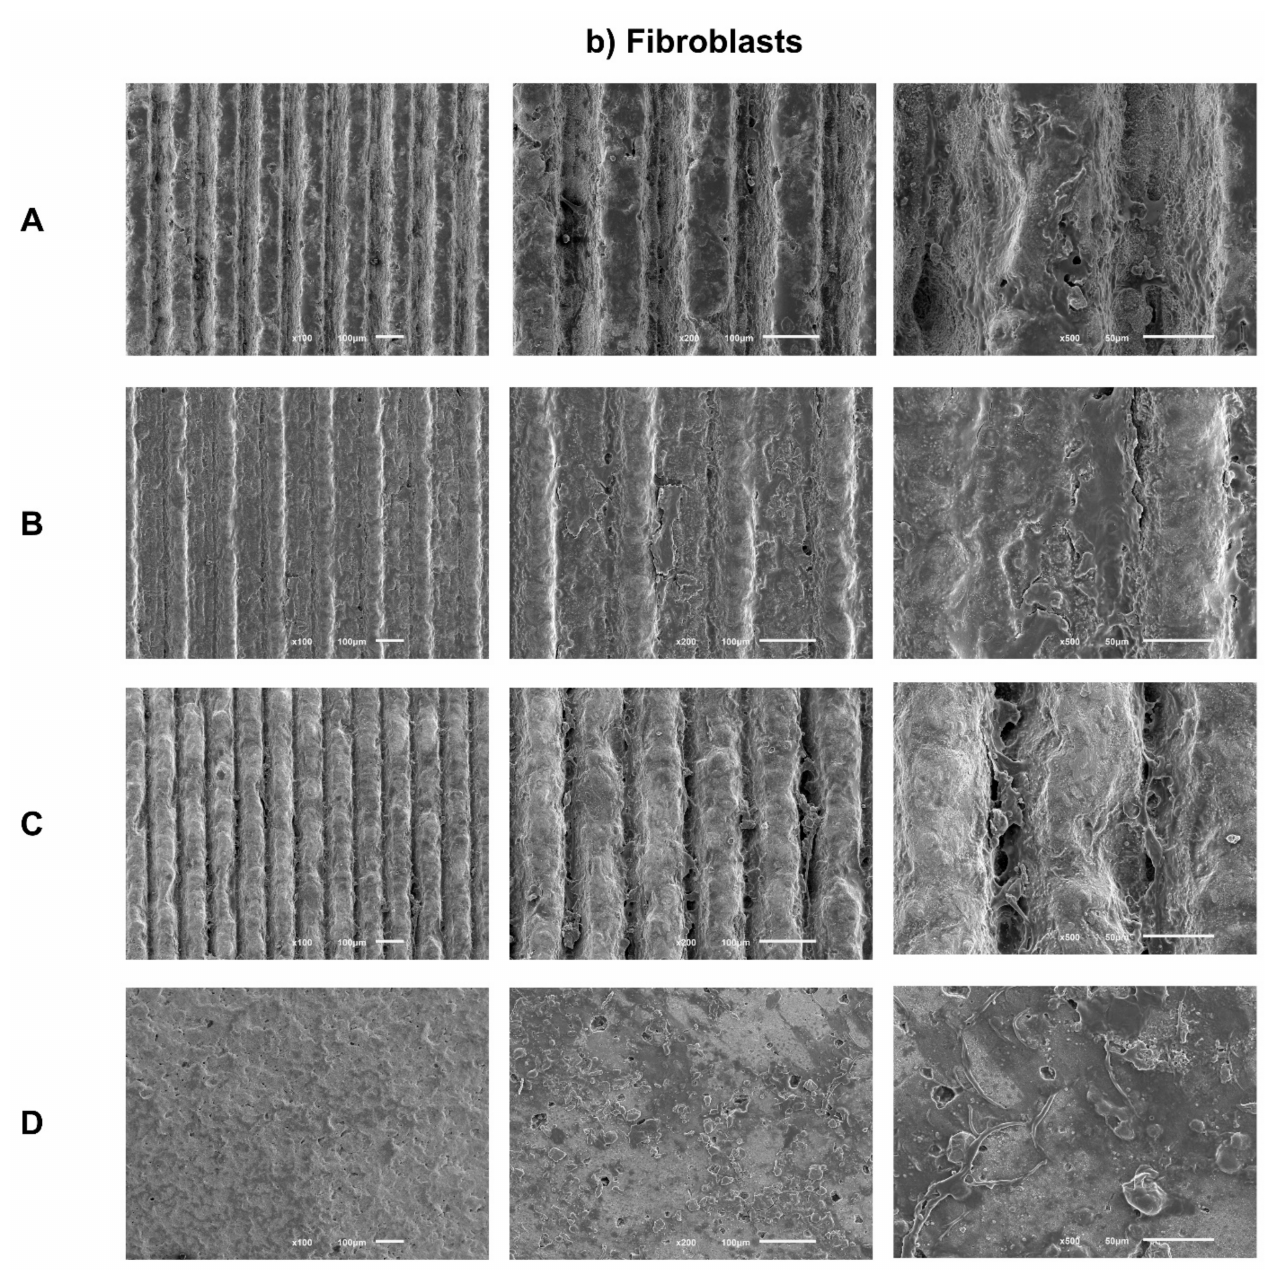
Figure 3. ( a ) Representative FEG-SEM micrographs of osteoblasts cultured on test samples and control surface after 1 day, with 100, 200, and 500 × magnifications for each study group (as described in Table 1). ( b ) FEG-SEM micrographs of fibroblasts cultured on test samples and the control surface after 1 day, with 100, 200, and 500 × magnifications for each study group (as described in Table 1). SEM images reveal adherent osteoblasts for all groups tested after just 1 day of culture. Osteoblasts cells had similar morphologies among all groups under study, with a more rounded cytoplasmic membrane and with less spreading of their cell bodies. A similar cell spreading within the grooves and in the space between them was observed. Thus, grooves’ texture by laser does not seem to influence osteoblasts distribution. However, cells inside grooves seem to be more rounded, while in the areas between them, cell bodies show greater spreading and cellular extensions. Cell distribution appears more homogeneous and the anatomy more regular over the entire surface of the control